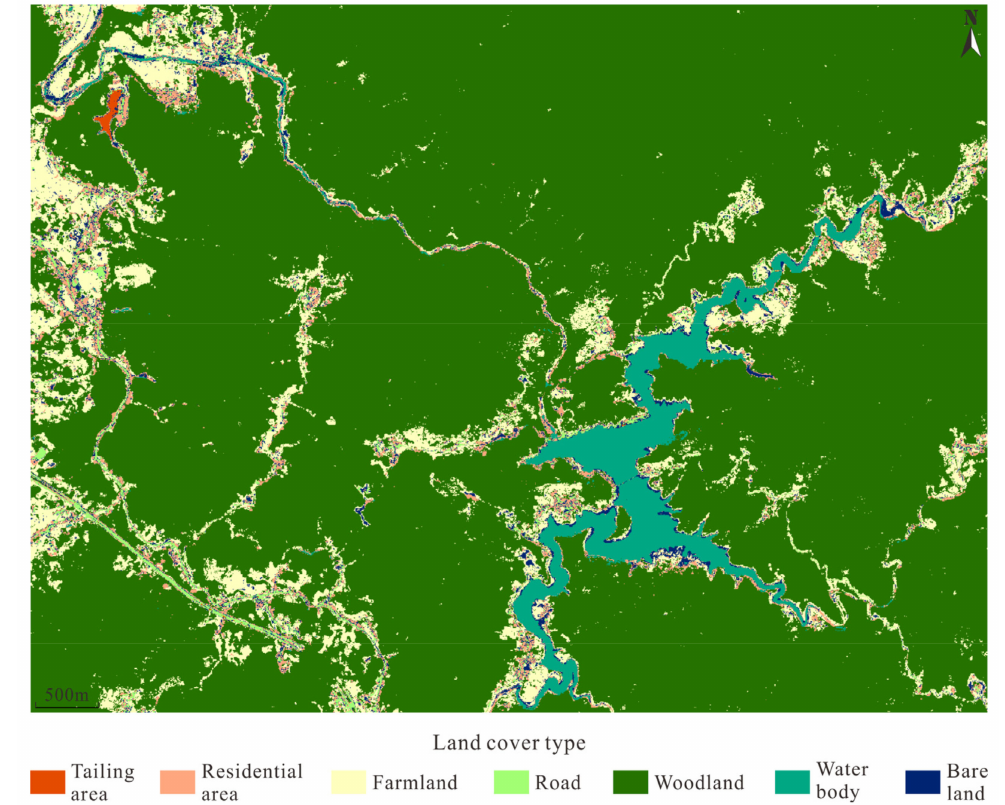
Figure 8. The obtained RF-based 2 m resolution land cover map of the study area using GF-1/PMS